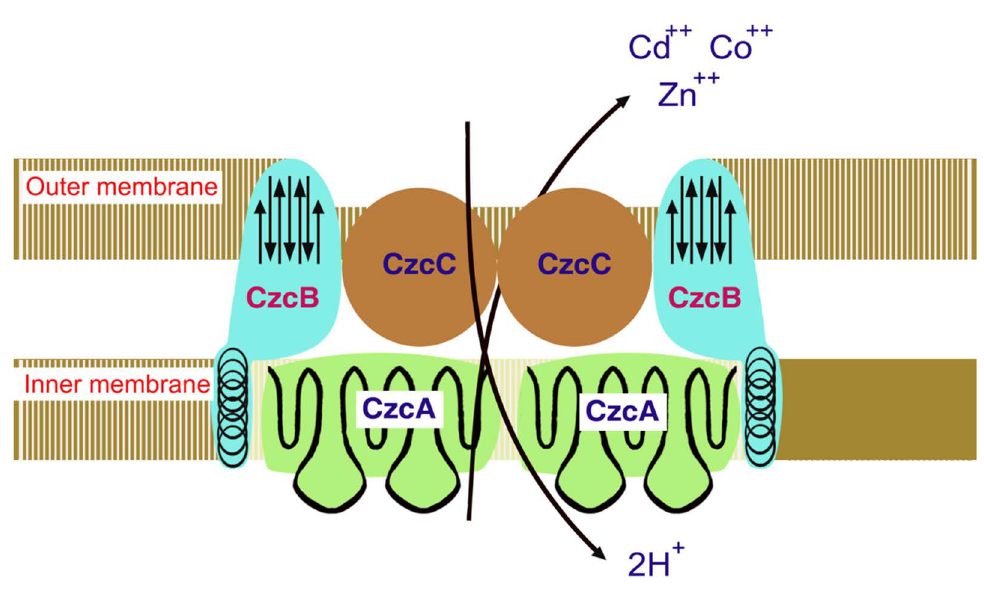
Fig 4. Czc model for Cd 2+ , Zn 2+ , and Co 2+ efflux system functioning as proton/cationantiporter consisting of inner membrane (CzcA), outer membrane (CzcC) and membrane fusion (CzcB) proteins functioning as a